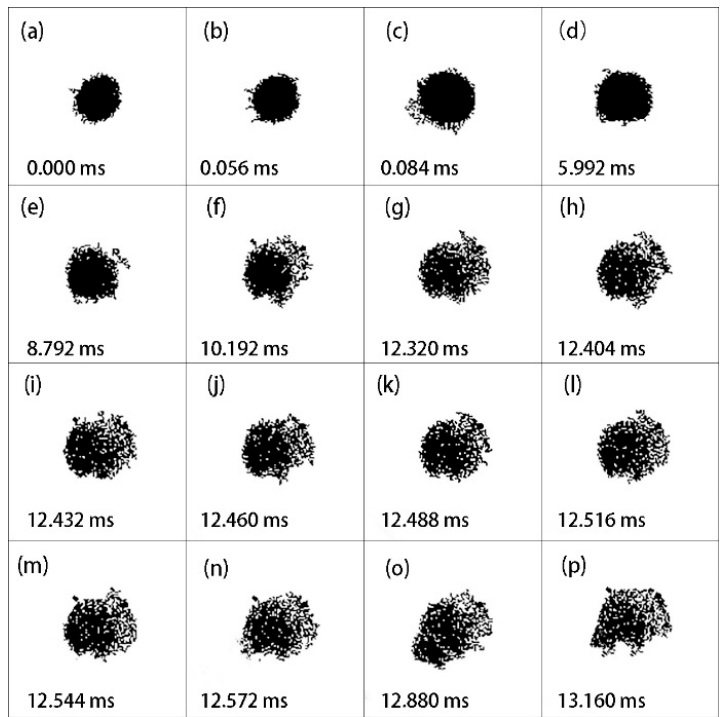
Figure 5. Representative pictures of laser ‐ induced ignition and combustion processes of an individual aluminum particle using digital imaging treatment. The initial diameter was 6.67 μ m. The laser power density was 7.56 × 10 5 W/cm 2 .